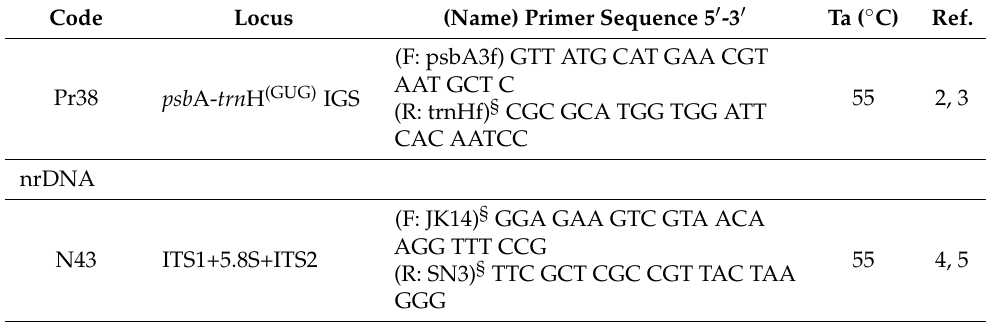
Table 2. Cont. Code Locus (Name) Primer Sequence 5 (cid:48) -3 (cid:48) Ta ( ◦ C)